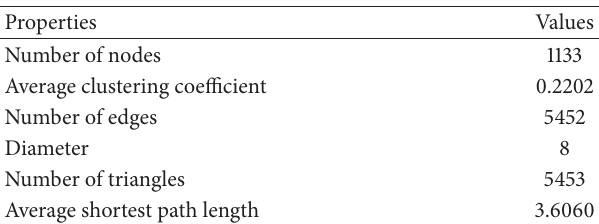
Table 3: Email dataset